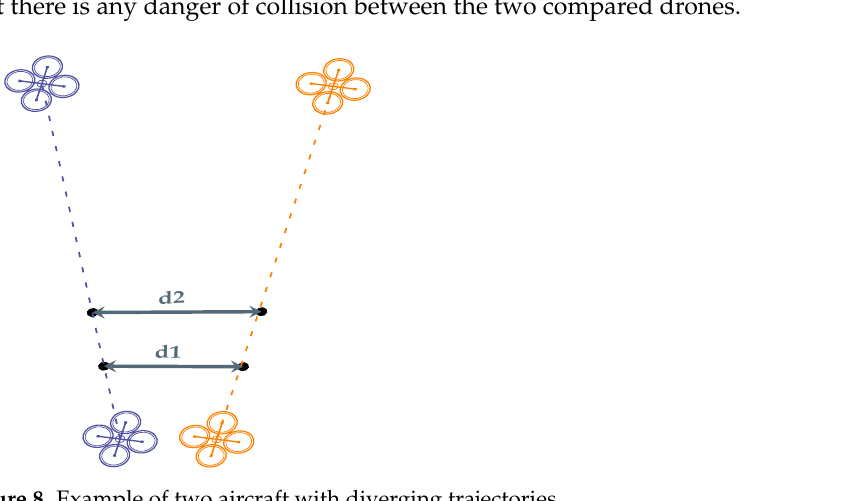
Figure 8. Example of two aircraft with diverging trajectories.